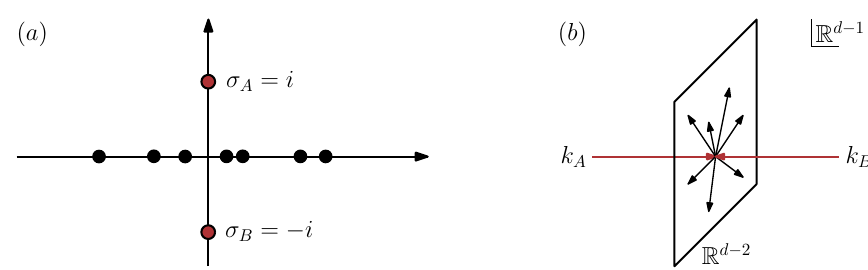
Figure 2 . (a) Con(cid:12)guration of particles for physical kinematics from section 5.4. The vertical forces exerted on particles 1 ; 2 ; : : : ; n 3 due to A and B are equal and opposite, making them stay on (cid:0) the real axis. (b) Corresponding 2 n 2 scattering process. Two massless particles of equal ! (cid:0)